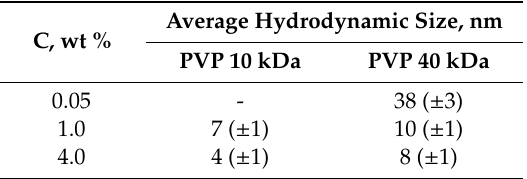
Table 2. Influence of the concentration of PVP on the average hydrodynamic size of AuNPs. The standard deviations are given in parentheses. Average Hydrodynamic Size, nm C, wt % PVP 10 kDa